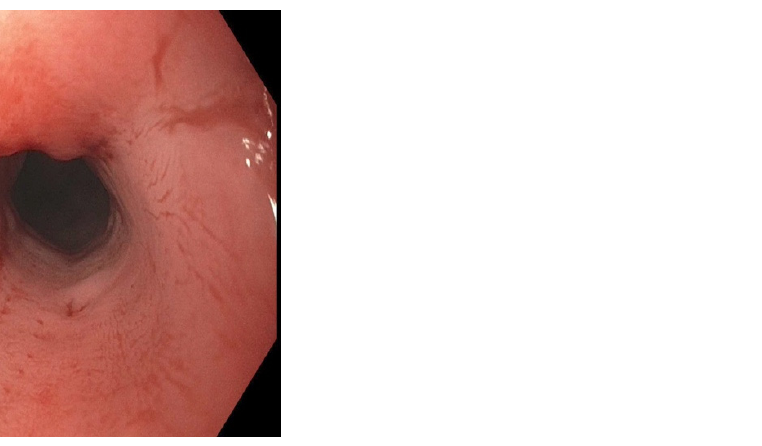
Figure 9. Endoscopy of the middle esophagus following balloon dilation of the stricture seven weeks post button battery ingestion.